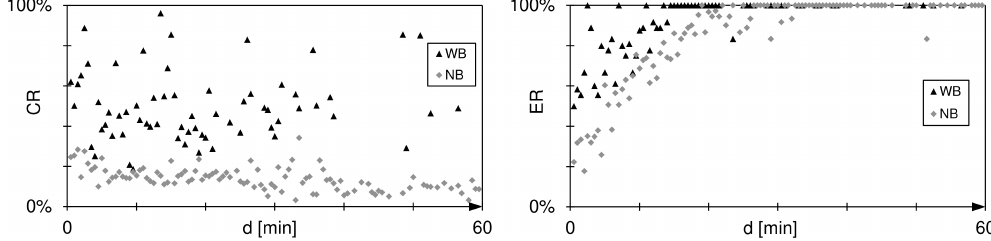
Figure 5. Compensation rate CR and success rate ER of compensating reactionary delay by increasing the cruising speed ( IACS ) for narrowbody and widebody aicraft.